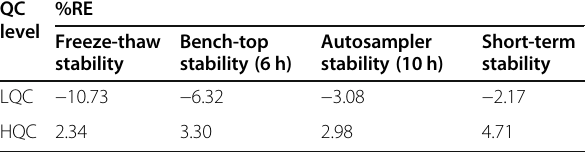
Table 3 Stability studies of LTZ in rat plasma